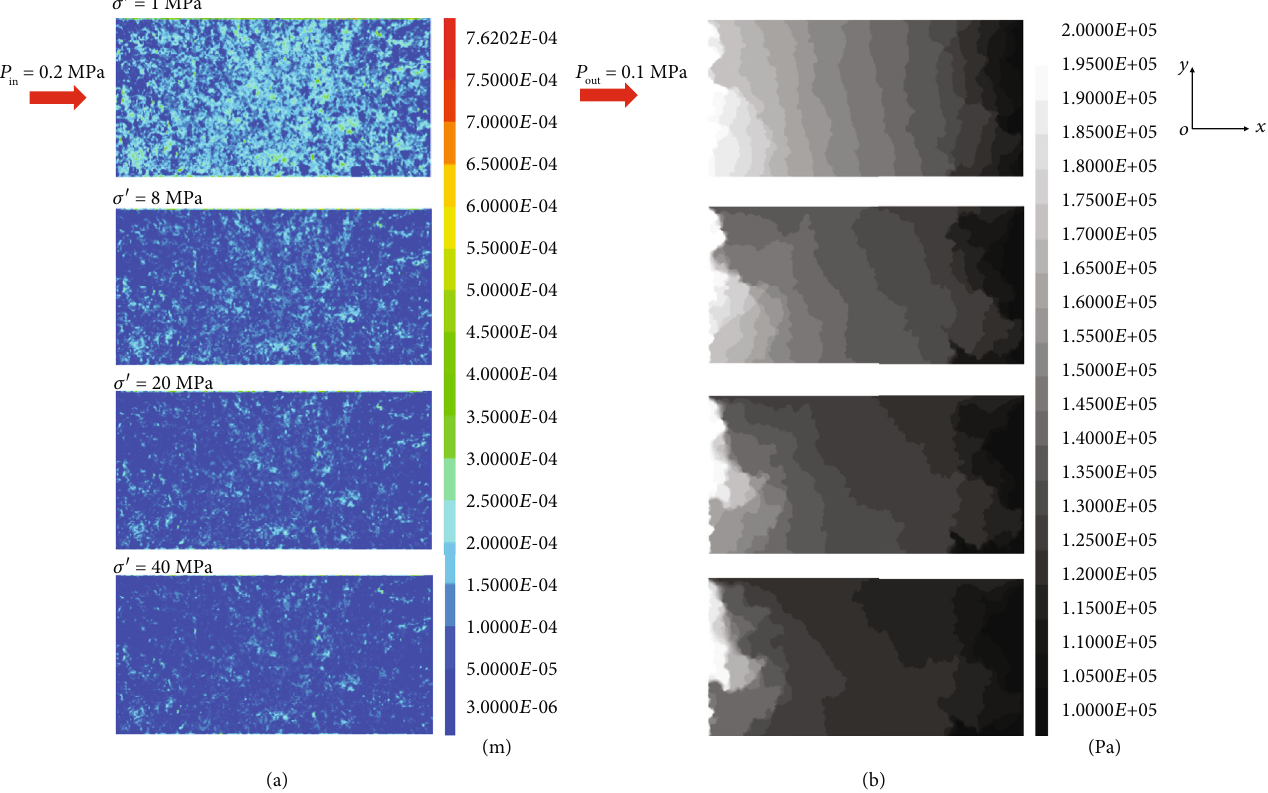
Figure 11: (a) Aperture and (b) pressure evolution for sample T3 under e ff ective con fi ning stresses of 1, 8, 20, and 40 MPa.